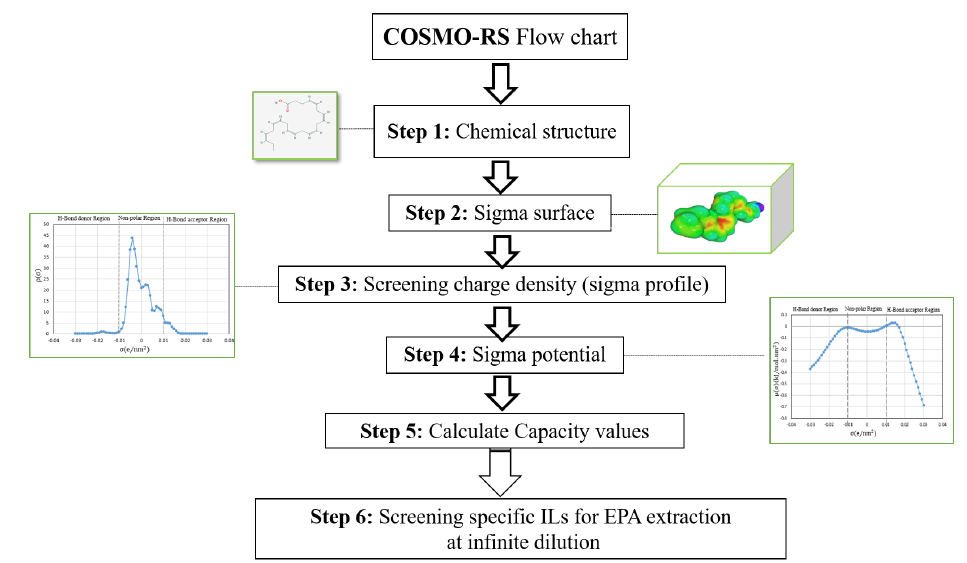
Figure 6. COSMO-RS calculation steps.